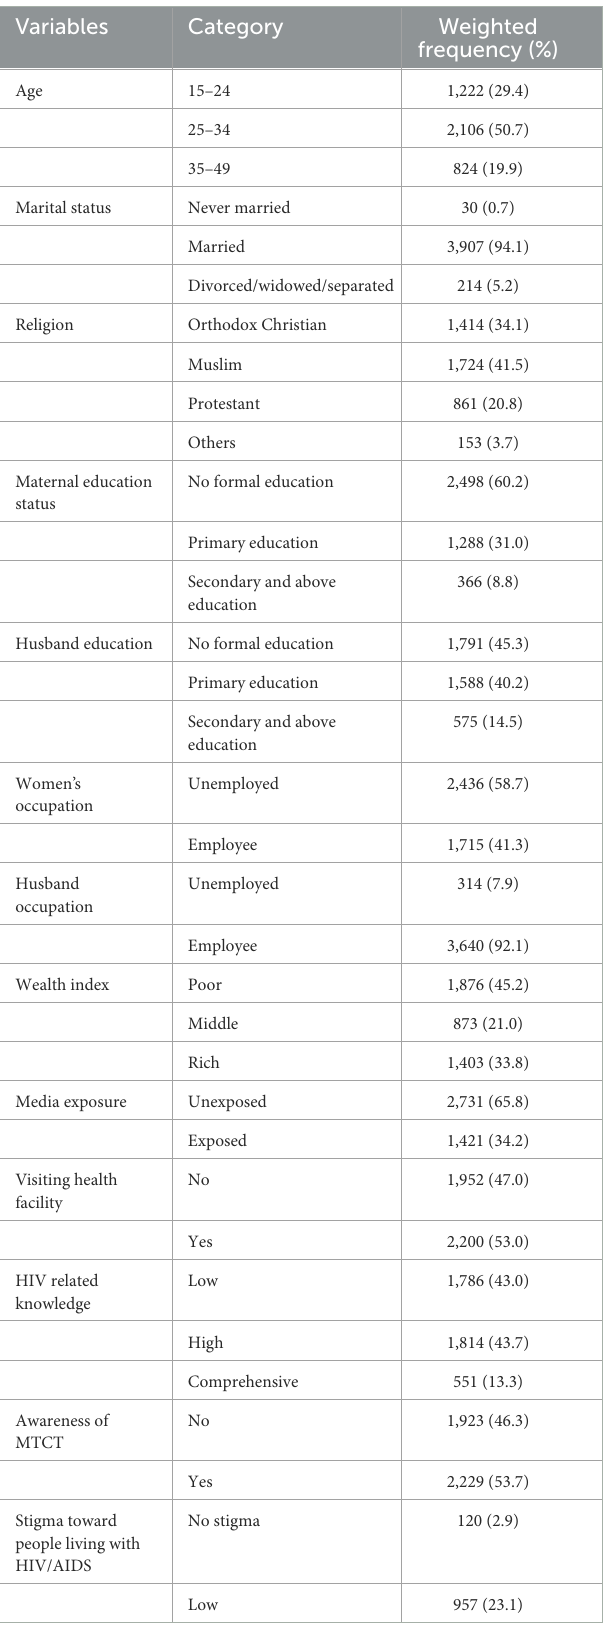
TABLE 1 Sociodemographic characteristics of study participants in a study of spatial variation and its determinants of prenatal HIV test uptake in Ethiopia based on the 2016